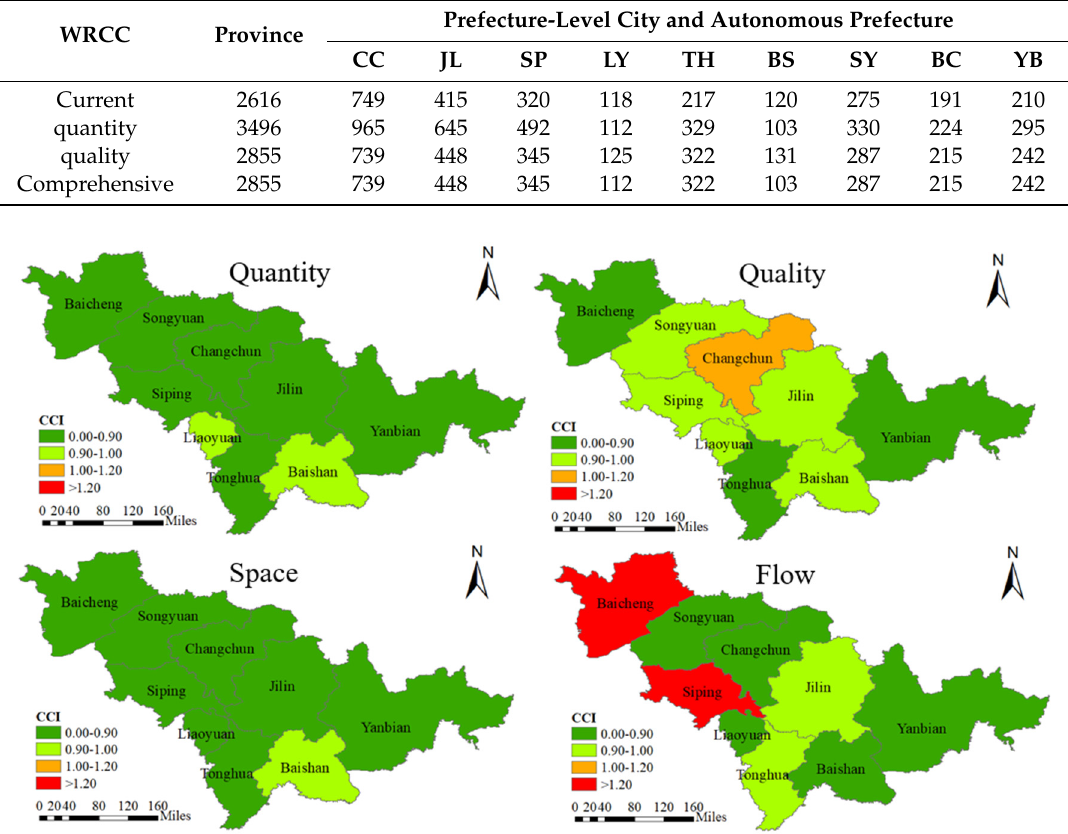
Figure 4. Carrying state of water resources.